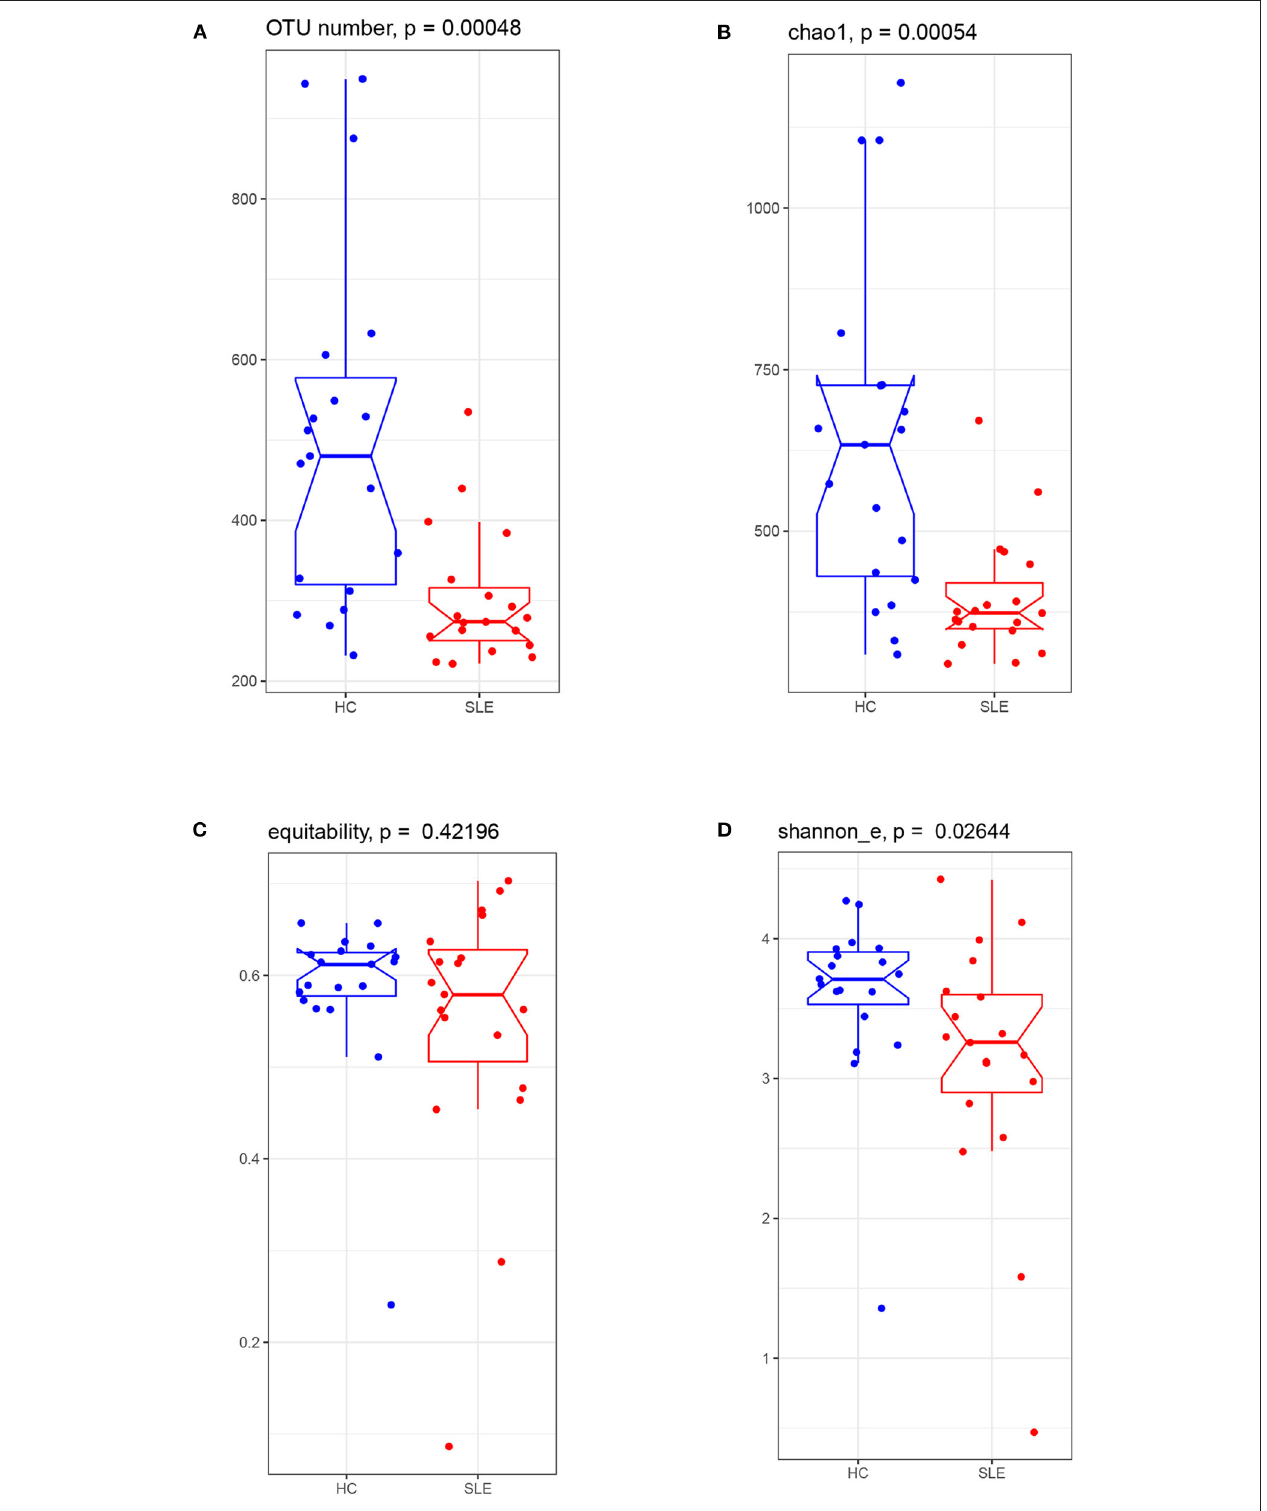
FIGURE 1 | The gut microbiota alpha diversity comparison between the SLE and HC groups. Boxplot visualized five summary statistics (the median, two hinges and two whiskers). Notches represented as median. The lower and upper hinges corresponded to the first and third quartiles (the 25th and 75th percentiles). The whisker extended from the hinge to the largest value no further than 1.5 * IQR (the distance between the first and third quartiles) from the hinge. Data beyond the end of the whiskers were outlying points. (A) observed OTU number, (B) richness index of Chao1, (C) equability, and (D) Shannon_e index.